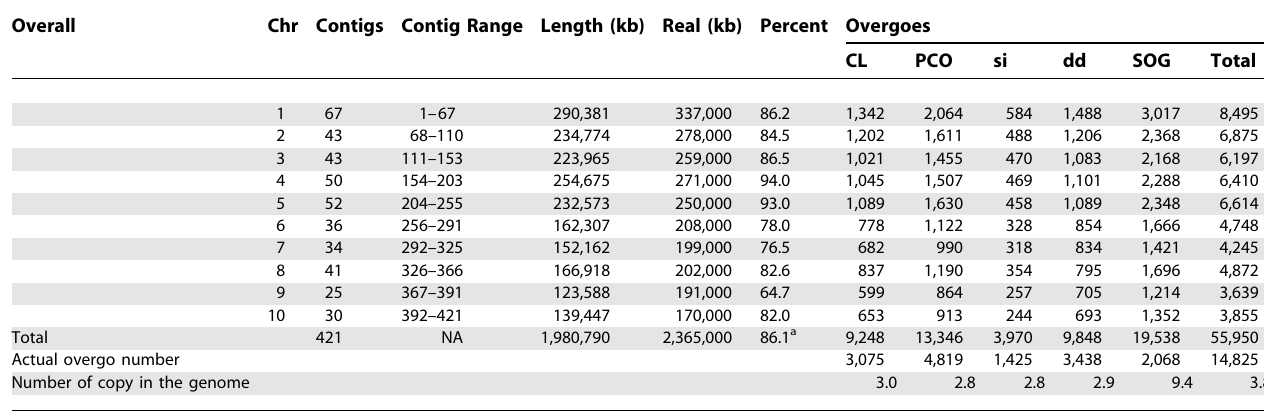
Table 2. Summary of the Maize Physical Map Overall